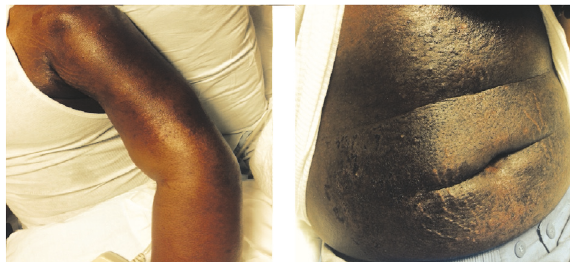
Figure 1: On physical exam, the patient was found to have a patchy,raised,nonulcerativehealingrashwithhypopigmentationon bilateral arms and forearms and anterior and lateral thighs, a patch of hyperpigmented rash on chest, and a diffuse rash over abdomen.